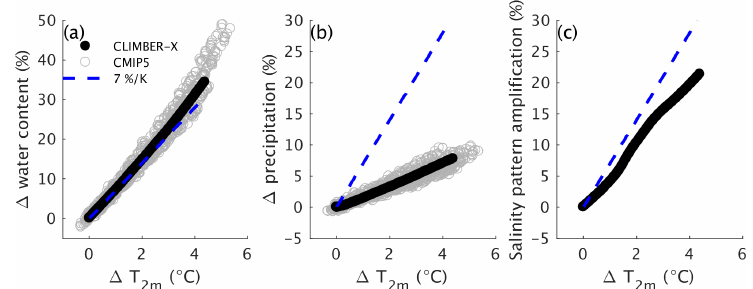
Figure 25. Relative (a) global water content change, (b) global precipitation change and (c) salinity pattern amplification versus global temperature change for the CLIMBER-X and CMIP5 models from the 1%yr − 1 CO 2 increase experiment. Each circle represents 1 year of the simulations.